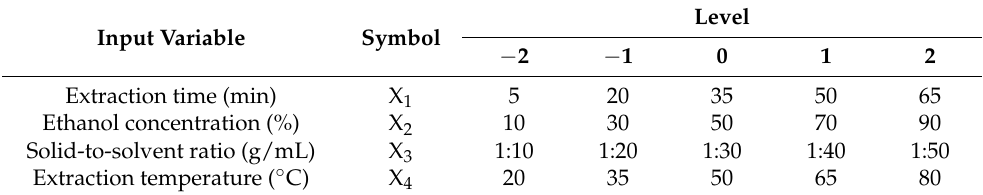
Table 1. Coded and actual levels of independent variables for the designed experiment.